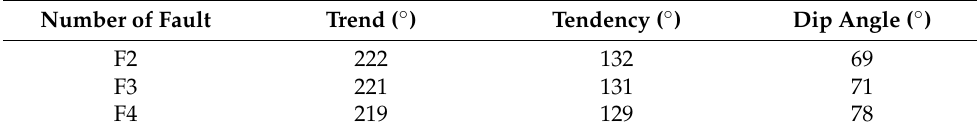
Table 1. Parameter table of the main fault in the footwall of the main orebody of Shizishan Copper Mine. Number of Fault Trend ( ◦ ) Tendency ( ◦